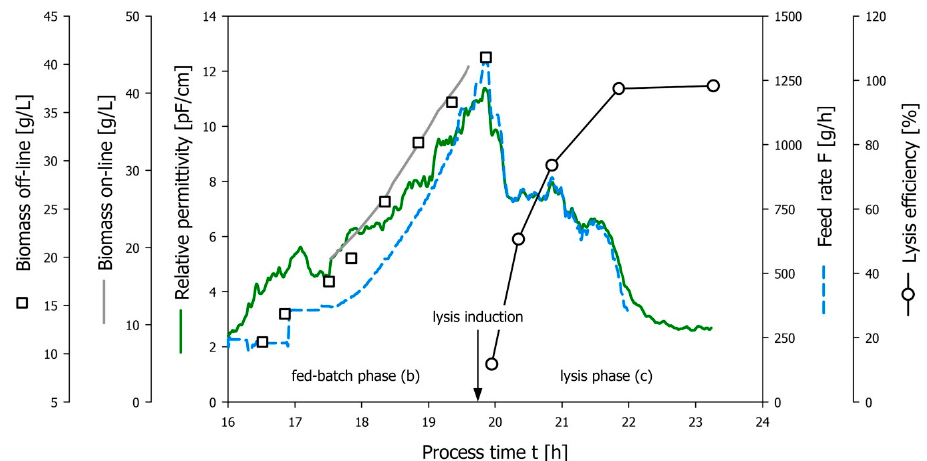
Figure 5. Demonstration of the described control method during the E-lysis phase. The feed-rate follows the permittivity signal nicely after lysis induction. The E-lysis efficiency (based on FCM data) increases over the duration of the lysis phase and reaches a value > 98%.